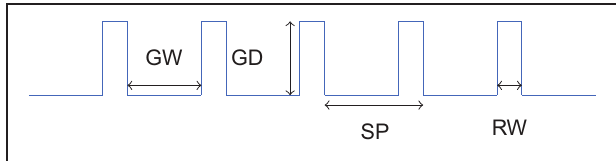
FIGURE 1 | Profile of periodic square wave gratings. Values of SP, RW, GW, and GD are shown in Table 2 .